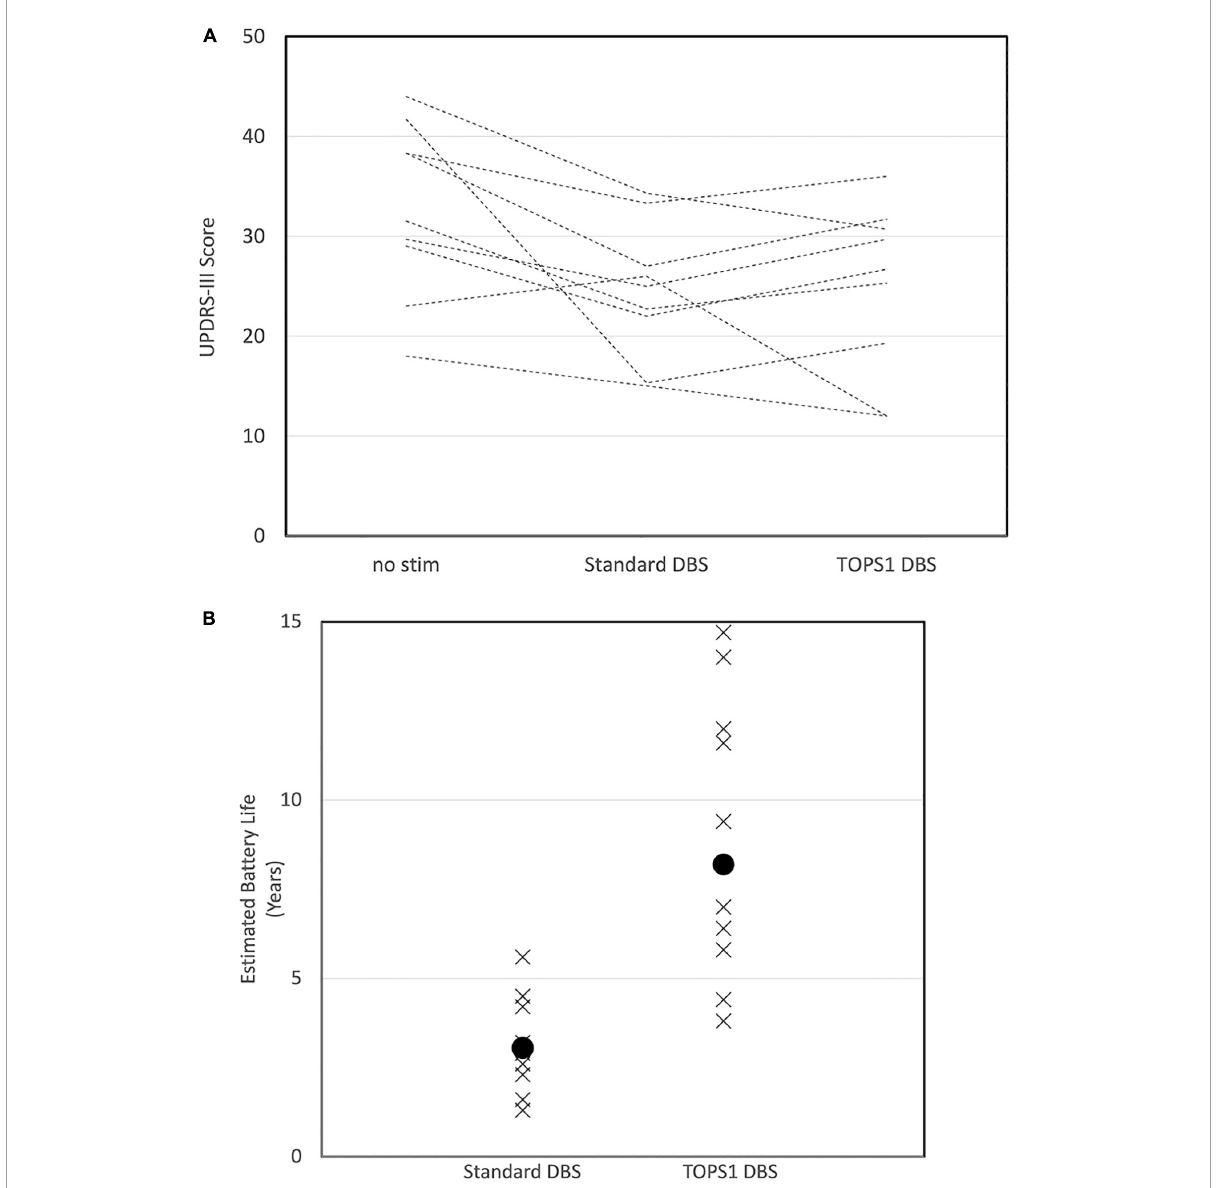
FIGURE4 Motor scores (UPDRS III) in subjects ( n = 9/19) for whom TOPS1 (average frequency = 45 Hz) was as effective or more effective than sDBS (A) . Subjects all have PD and STN DBS and were tested while on Parkinson’s medications. Estimated implanted pulse generator battery life for sDBS and TOPS1 DBS (B) in nine subjects in which TOPS1 was as effective or more effective than sDBS. Median estimated battery life was significantly increased with TOPS1 DBS ( S = 27.5, p =